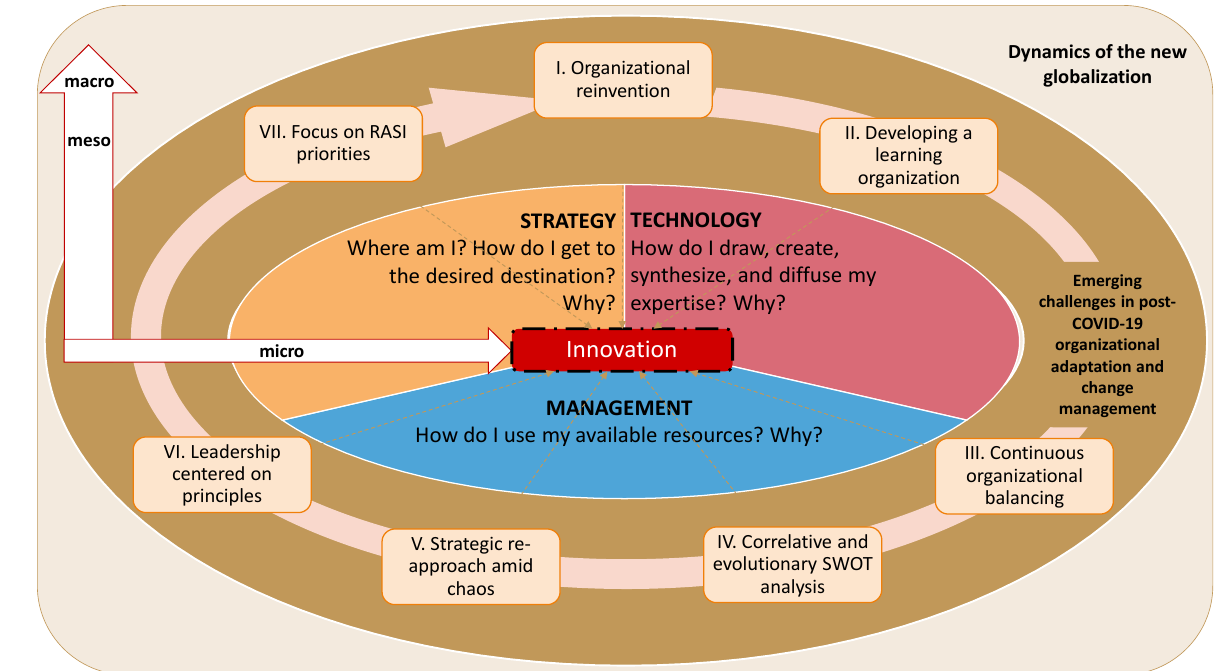
Figure 3. The suggested integrative approach to organizational readaptation.